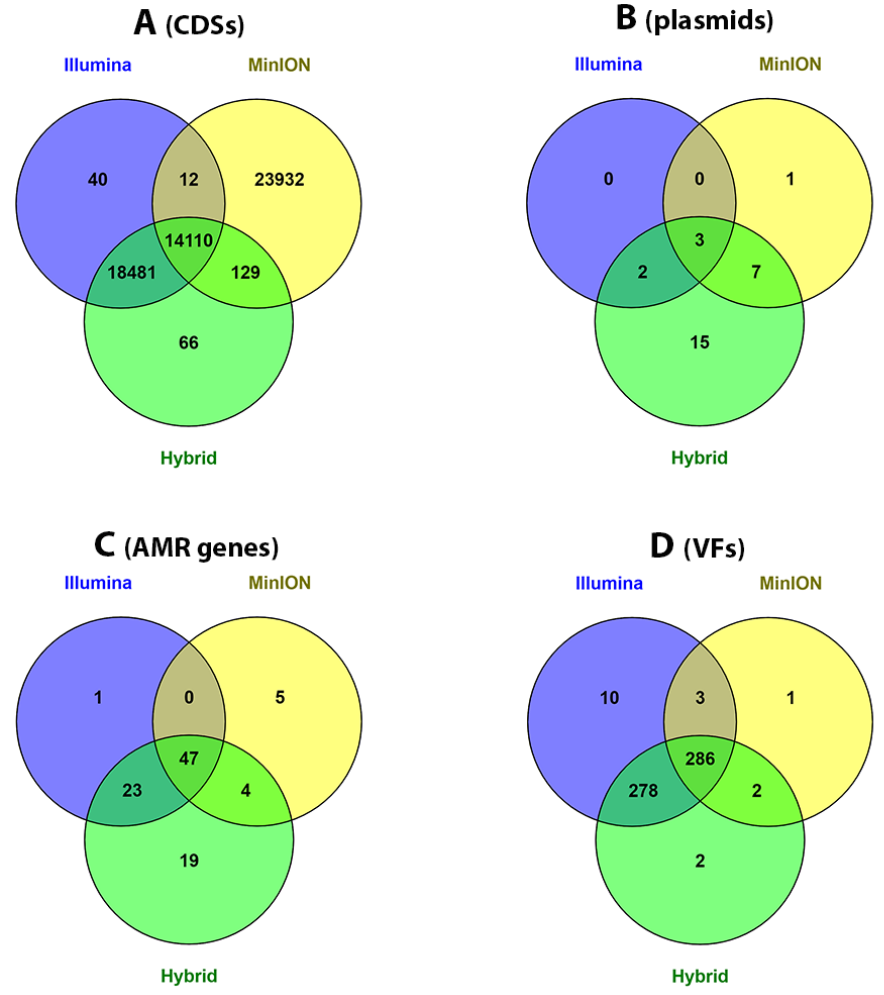
Figure 3. An overview of downstream analysis results for different assemblies created using the top- performing assemblers. Venn diagrams prepared using the Venny online platform to plot differences in the number of annotations obtained, in which data for four E. coli and five K. pneumoniae isolates were merged. Numbers in the overlap area indicate the mutual hit names (hits identified in the exact same isolates). ( A ) The number of annotated CDSs (putative and hypothetical proteins not plotted). ( B ) The number of identified and confirmed plasmid contigs using PlasmidFinder and Bandage visualization tools, respectively. ( C ) The number of AMR genes, including both acquired and point mutations. ( D ) The number of identified VFs.